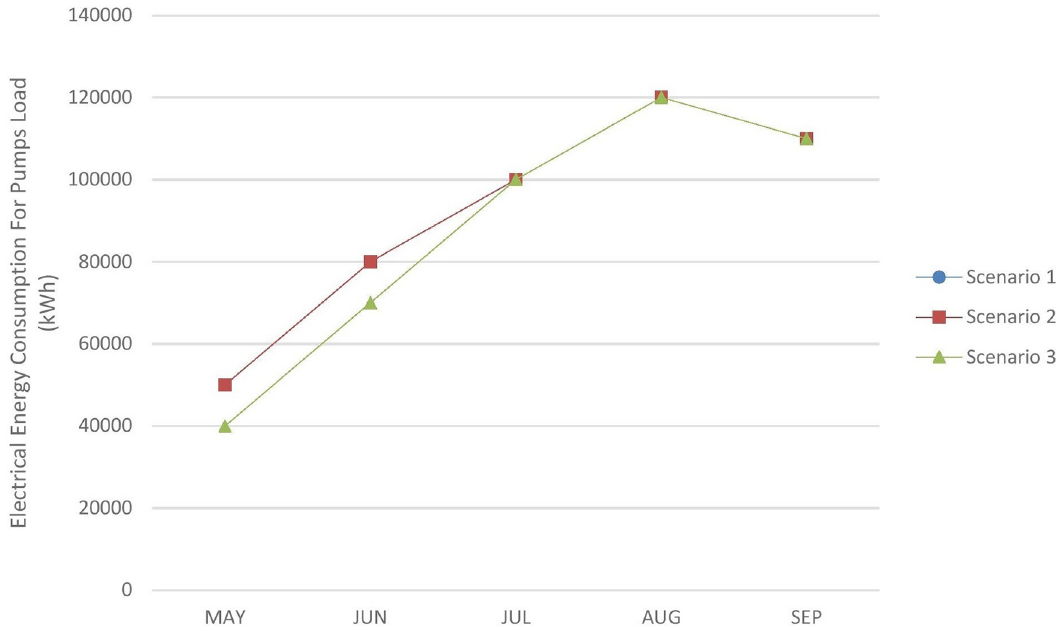
Fig. 11. Variable fl ow circulation pump electrical energy consumption for screw